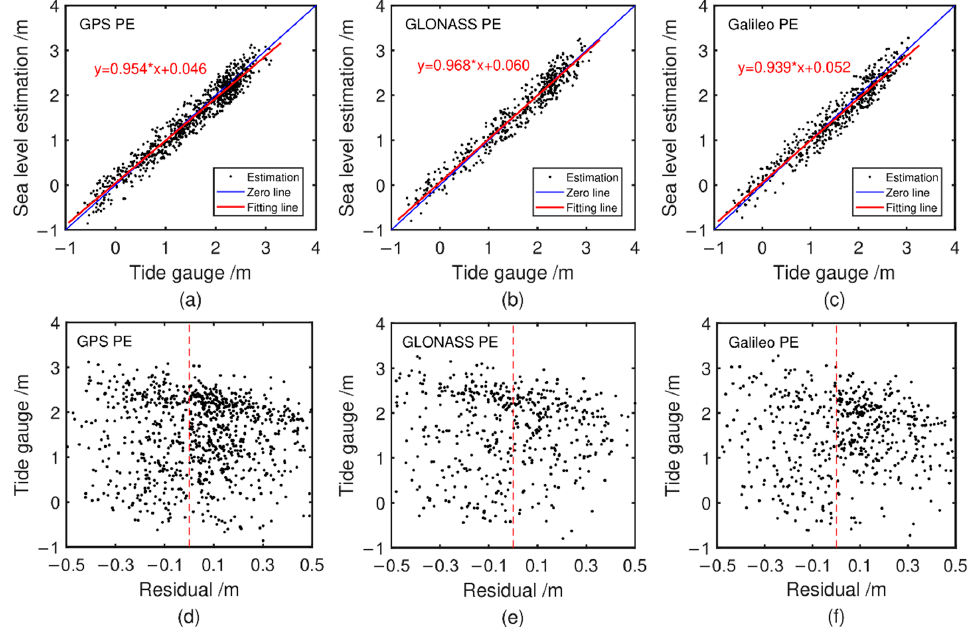
Figure 12. Performance of sea surface height with different GNSS observations for site SC02. ( a – c ): Linear relationship of sea-level variations estimated from GNSS PE arcs versus the in situ results recorded by tide gauge; ( d – f ): Van de Casteele diagrams (GNSS-estimated sea-level residuals versus in situ